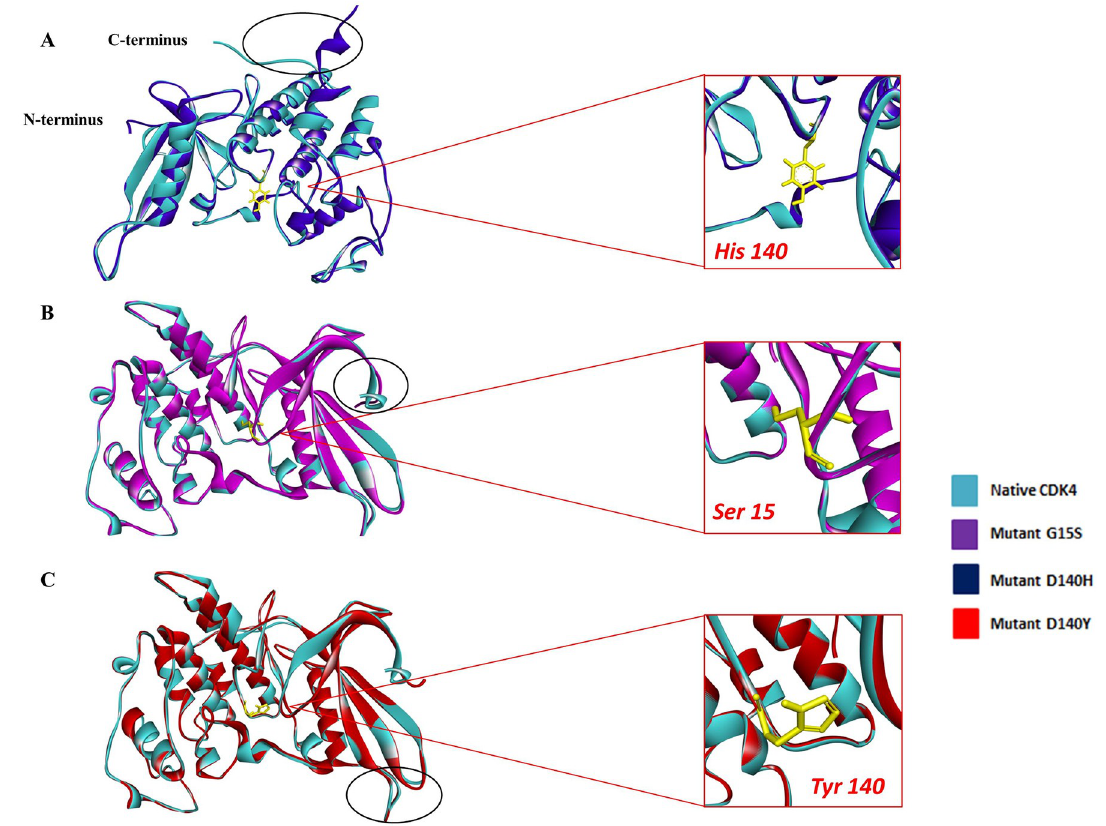
Fig 4. Superimposed structure of native and mutant proteins. (A) Native CDK4 superimposed with D140H mutant (B) Native CDK4 superimposed with G15S mutant and (C) Native CDK4 superimposed with D140Y mutant. Deviation of structural changes is shown in circle. Total RMSD was found 1.32 Å for mutant G15S; 0.94 for mutant D140Y and 1.04 Å for mutant